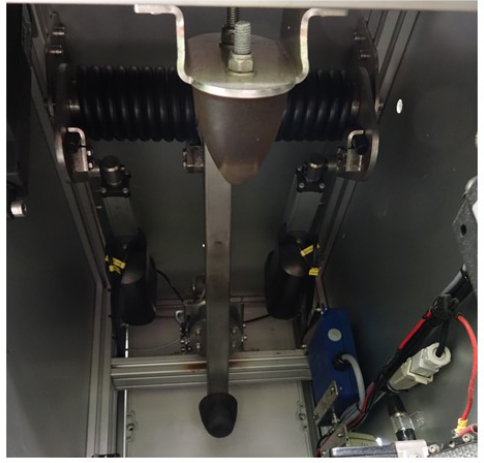
Figure 4. Ball Training Machine kicking mechanism.